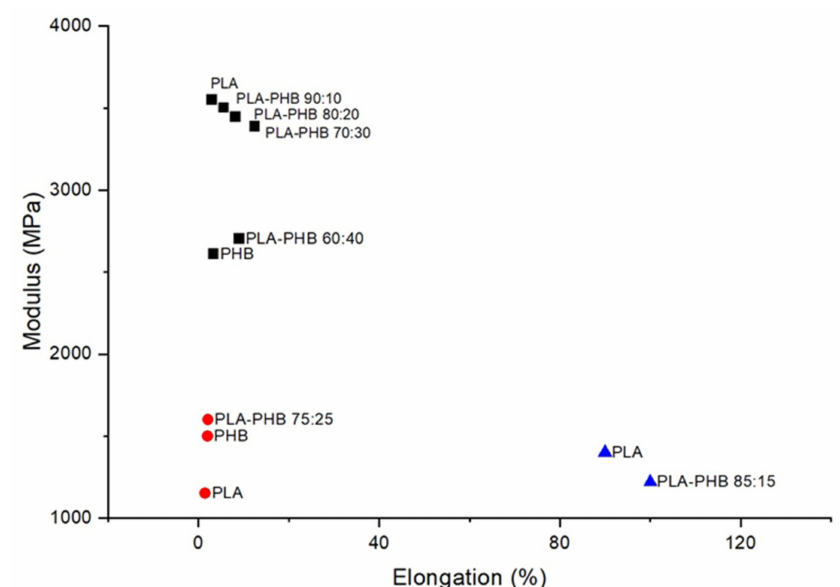
Figure 6. Young’s Modulus (MPa) vs. elongation at the break (%) of PLA, PHB and their blends, reported by Jandas et al. (black squares), Data from Ref. [57], Armentano et al. (blue triangles), Data from Ref. [91] and Arrieta et al. (red circles), Data from